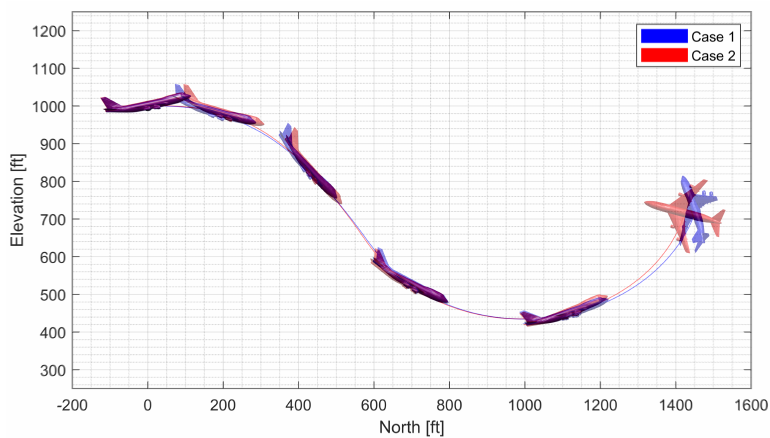
Figure 10. Flight trajectory of the push-over and pull-up